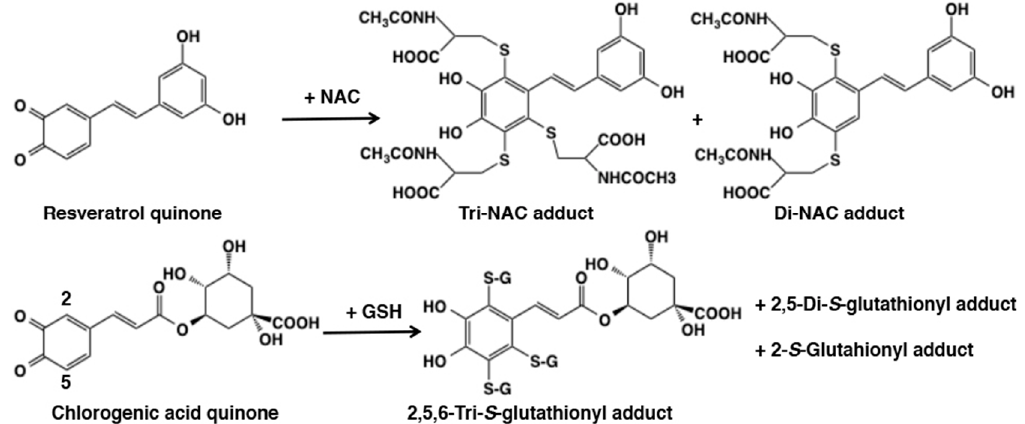
Figure 6. Reaction of resveratrol quinone and chlorogenic acid quinone with thiols [35,37]. Note that the C2 position is most reactive.